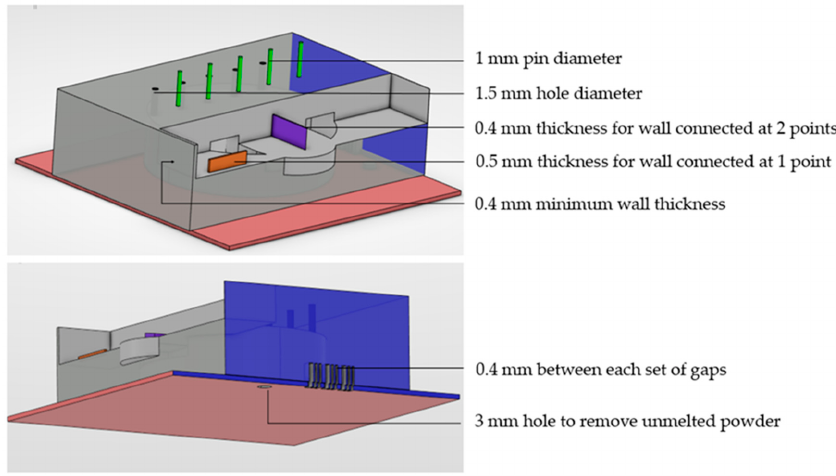
Figure 3. Example of applying DfAM geometrical recommendations in the part design.